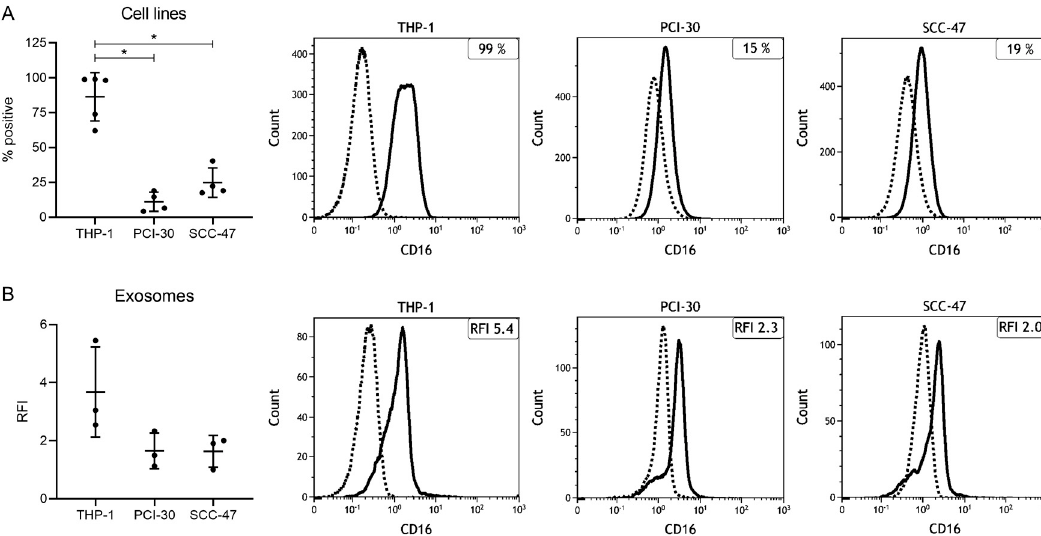
Figure 2. CD16 levels on cells and cell-line derived exosomes. ( A ) The monocytic cell line THP-1 and the two HNSCC cell lines PCI-30 and SCC-47 were stained for CD16. ( B ) Exosomes produced from the three cell lines were stained for CD16 and surface levels are shown as relative fluorescent intensity (RFI) compared to an appropriate isotype control. Bars represent mean with standard deviation (SD) from n = 5 ( A , THP-1) or n = 4 ( A , PCI-30, SCC-47) and n = 3 ( B ) independent flow cytometry experiments. p values were determined by Mann–Whitney test, with * corresponding to p ≤ 0.05. Representative flow cytometry histograms depicting CD16 levels on the individual cell lines ( A ) and their corresponding exosomes ( B ) are shown. The solid line represents the CD16 signal, the dashed line represents the unstained ( A ) or isotype ( B ) control.